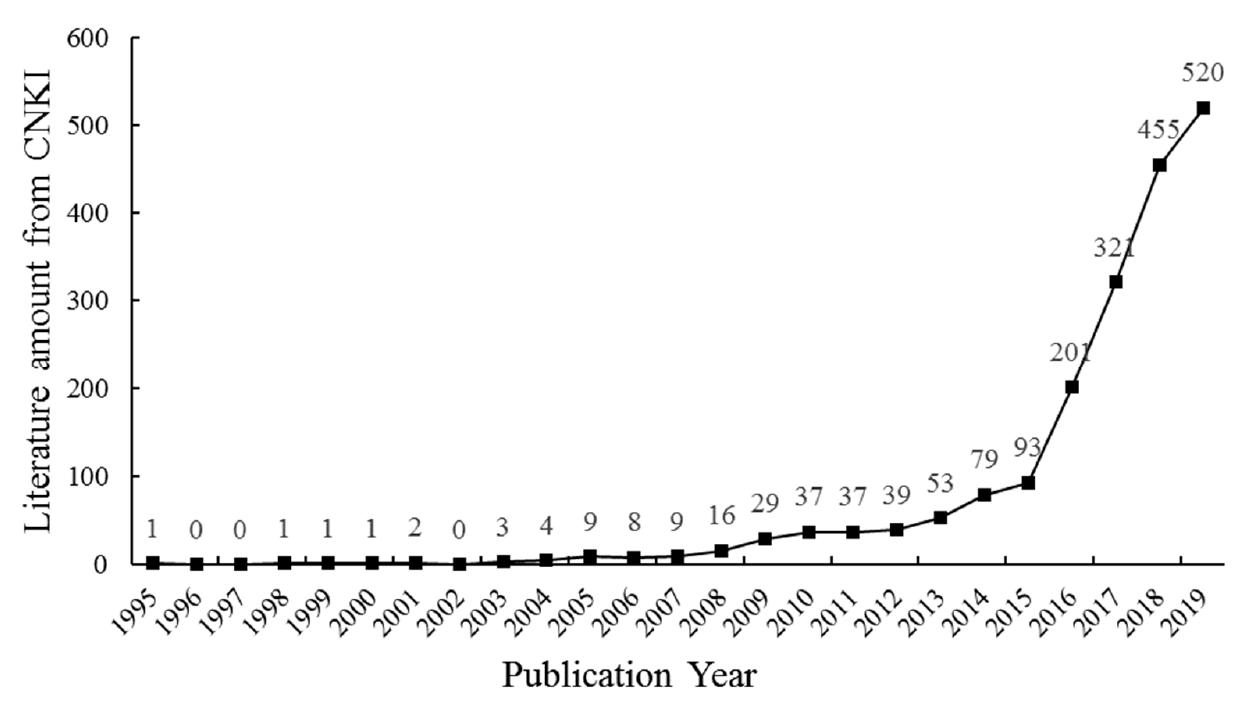
Figure 2. Publication trend of UAV-LARS applications in agricultural monitoring of China (1995–2019).